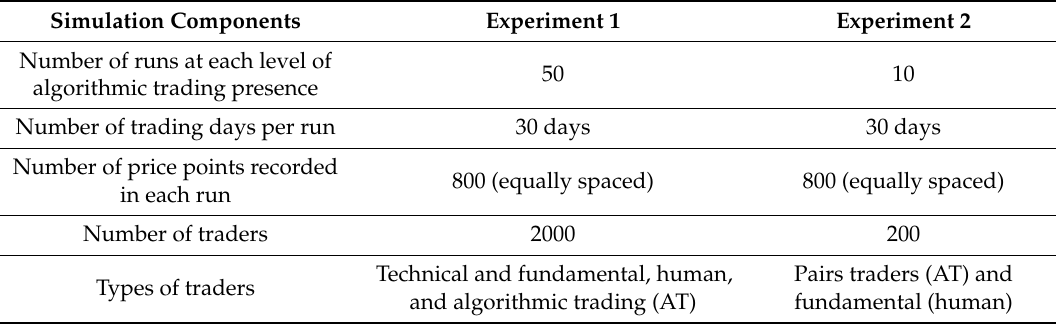
Table 1. Simulation details of each